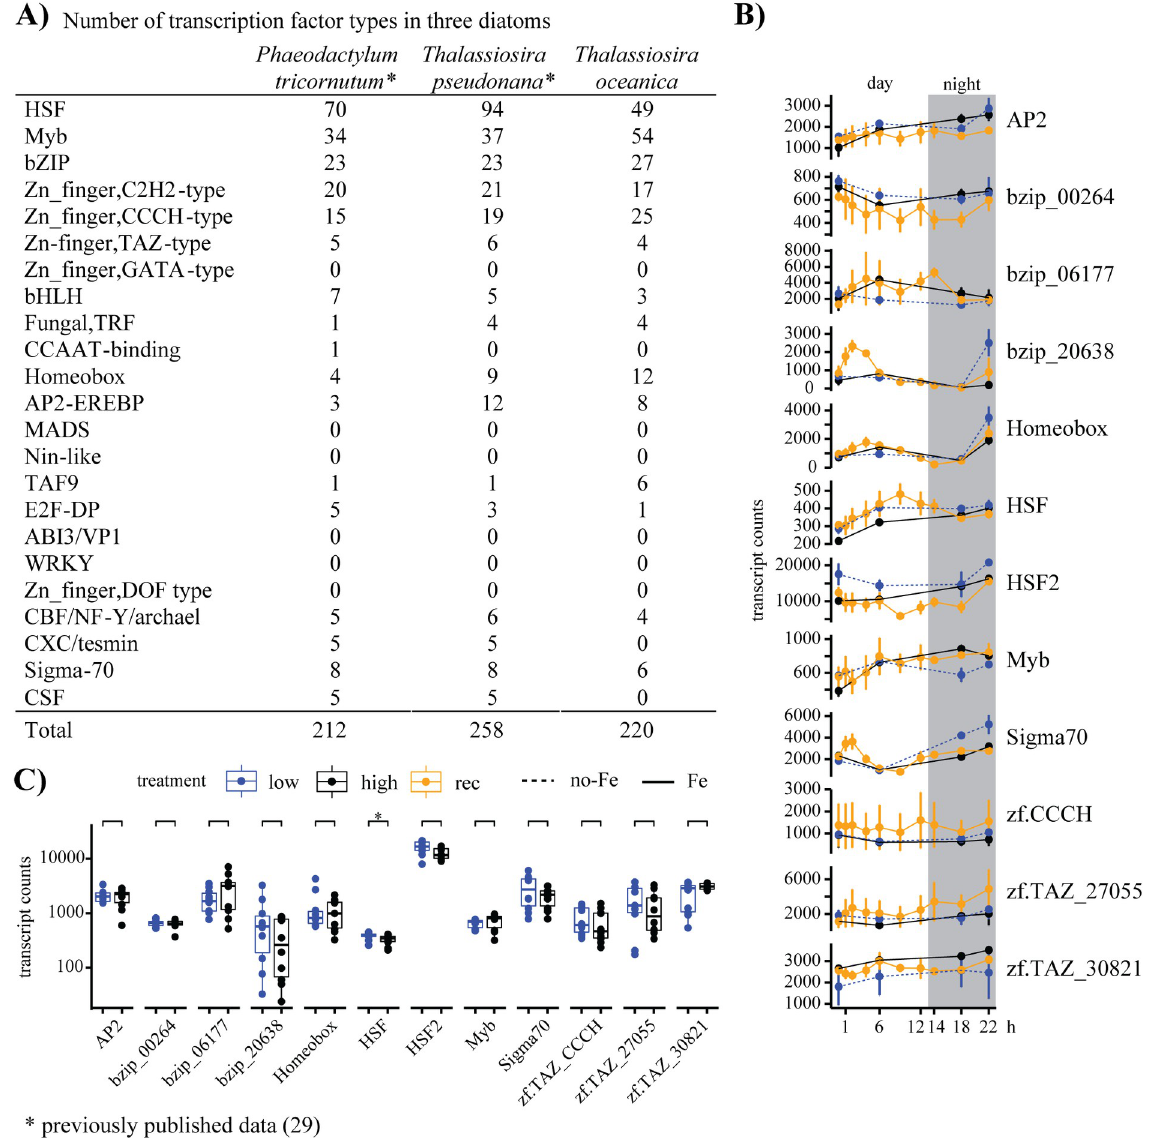
Fig 7. Putative transcription factors in T . oceanica and their transcript levels. (A) Comparison of previously published data on transcription factors in P . tricornutum and T . pseudonana [34] to T . oceanica . (B) Expression patterns of the transcription factors from high- iron (black), low-iron (blue), and iron-recovery (orange) treatments. Transcript counts are on the y-axes, and time (h) is on the x-axis. The grey box indicates the dark phase. (C) Transcript counts of high- (black) and low-iron (blue) treatments. A two-tailed Student’s t-test was used for statistical analysis. Transcript counts are on the y-axis, and the gene names are indicated on the